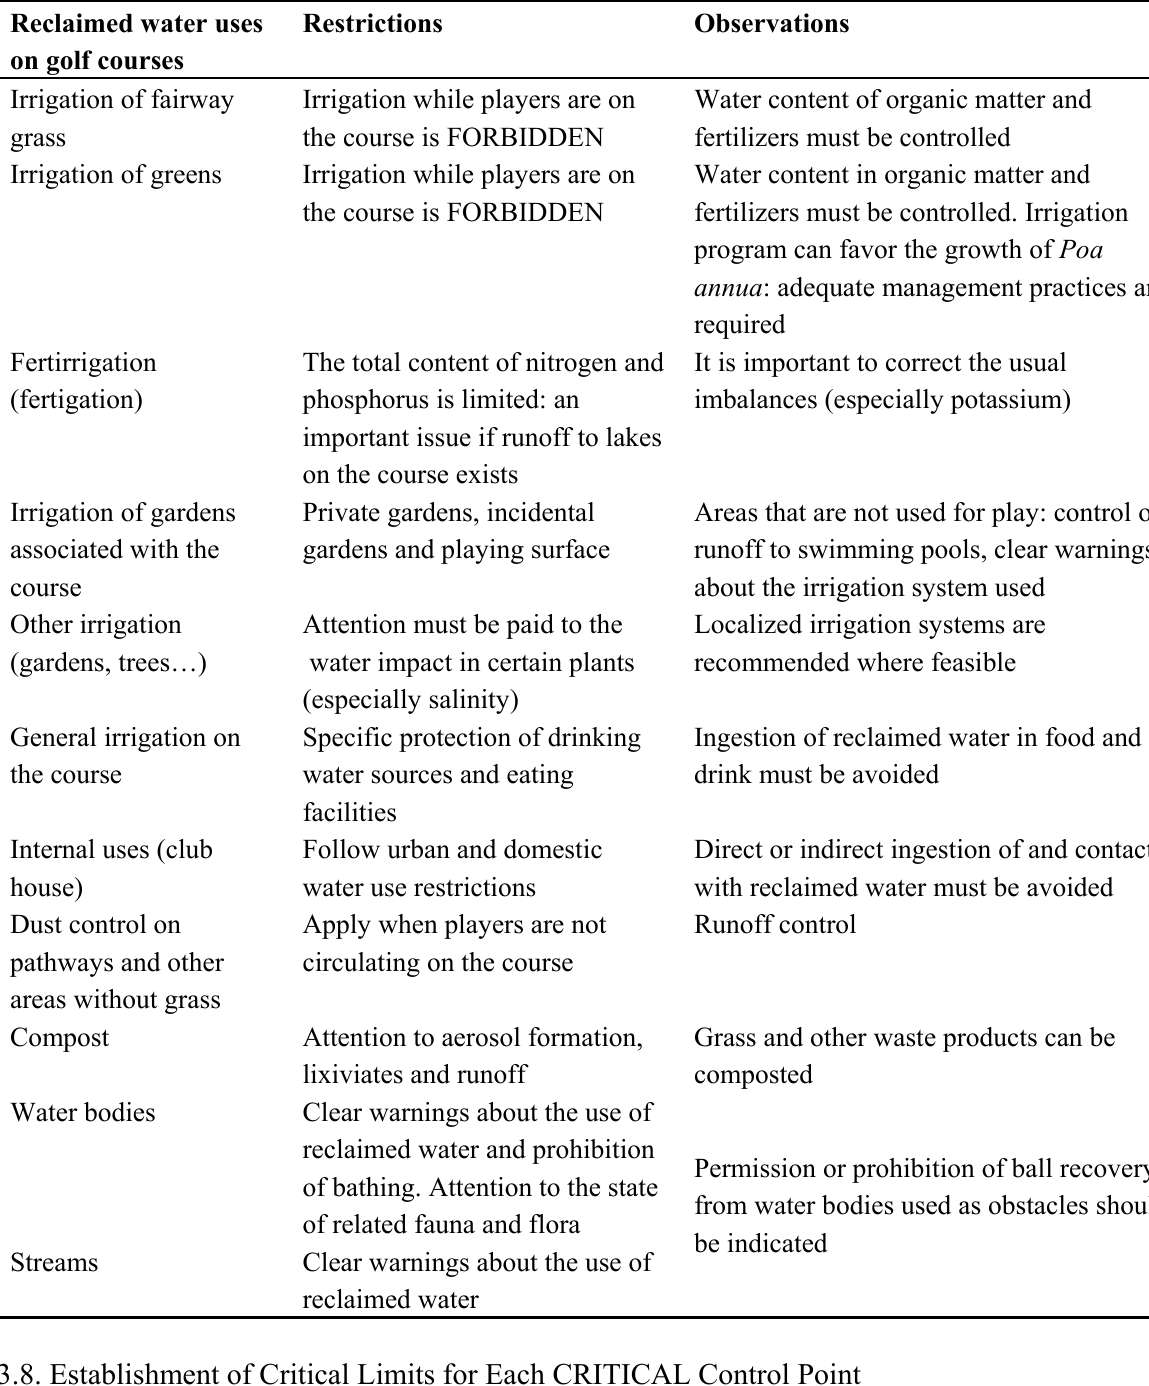
Table 19. Reclaimed water uses on golf courses and restrictions to